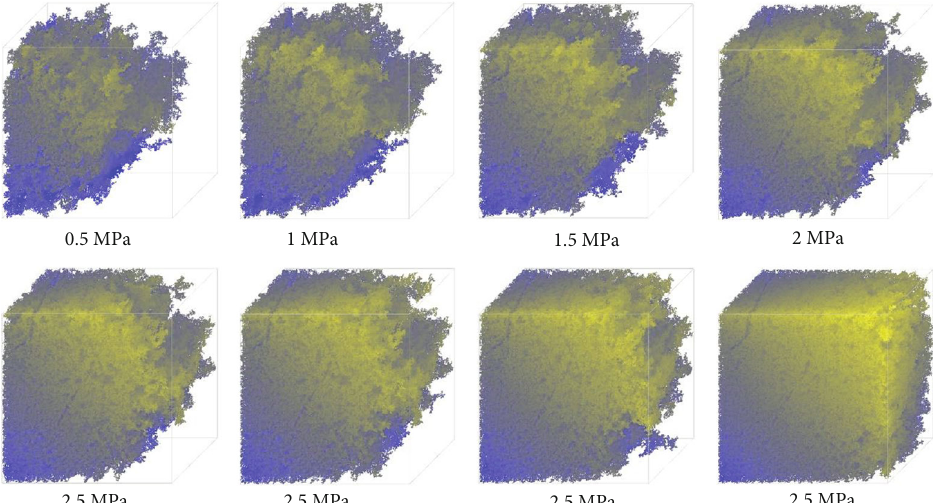
Figure 12: The spatial distributions of the largest clusters in coal samples.